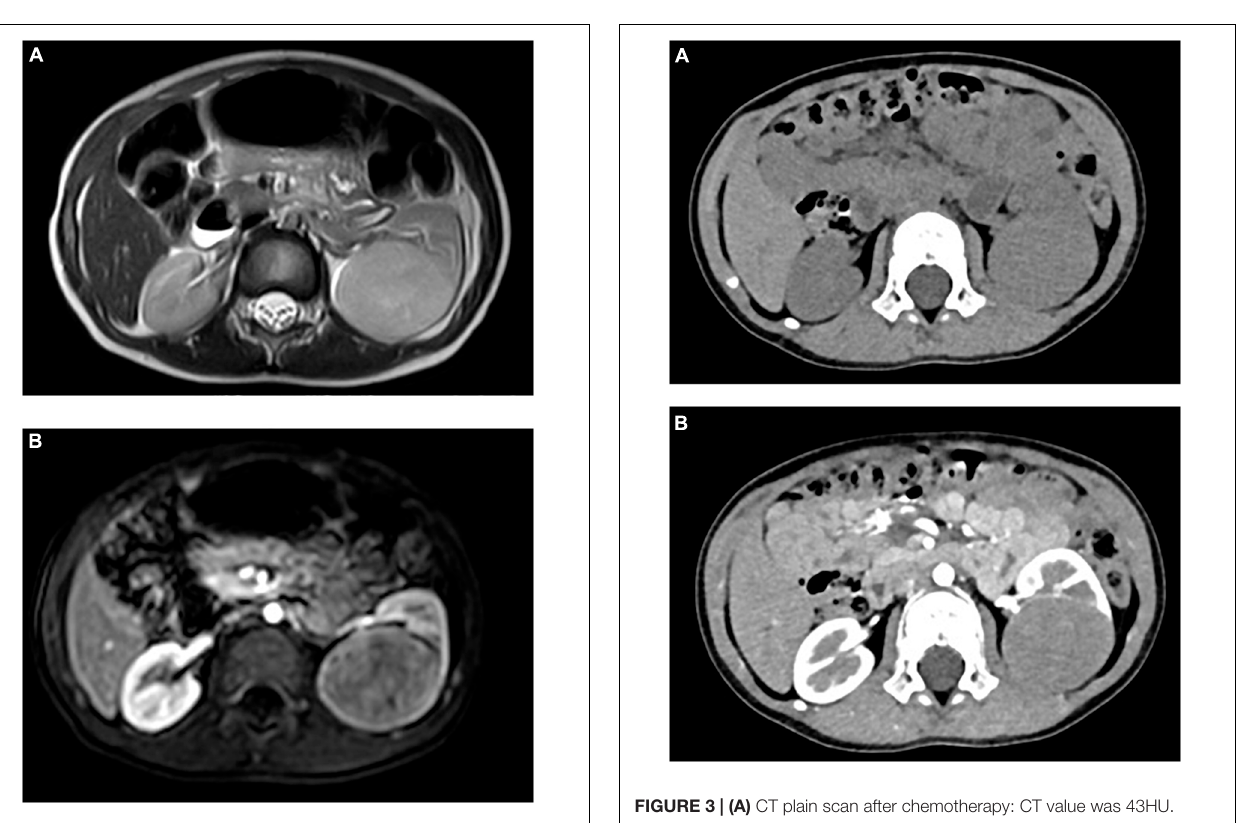
FIGURE 2 | (A) MRI plain scan before chemotherapy: equisignal on T1WI, slightly higher signal on T2WI, significantly higher signal on DWI, and low signal on ADC. (B) MRI enhancement before chemotherapy: dynamic enhancement showed delayed uneven enhancement, and the degree was weaker than that of renal cortex.